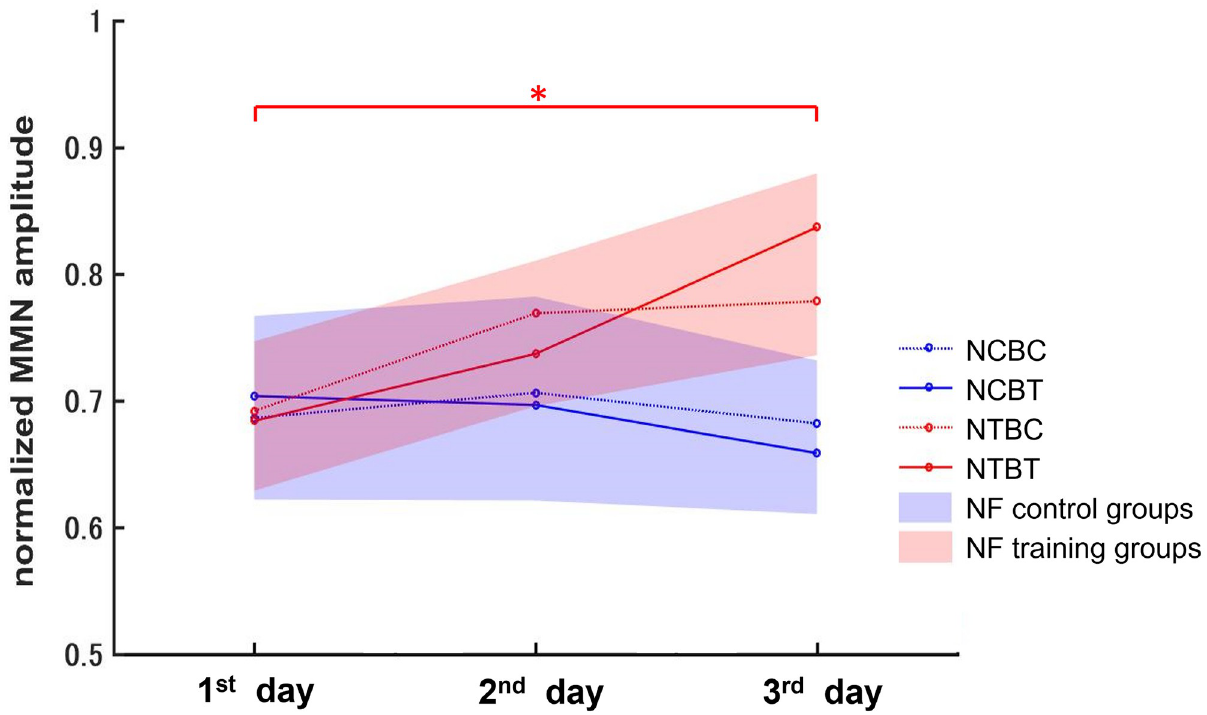
Fig 6. Results of changes in neural activity. Normalized values of average MMN amplitudes for all participants on each training day in the four groups (NCBC group: blue dotted line; NCBT group: blue solid line; NTBC group: red dotted line; NTBT group: red solid line). The range of the blue line width represents the SEM for the group without NF training, and the red width range represents the SEM for the group with NF training; � p < 0.05.